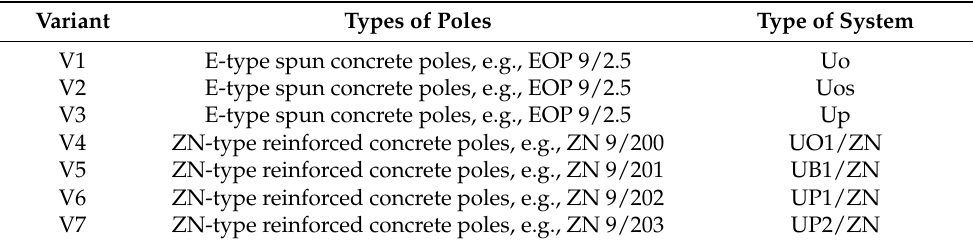
Table 3. Pole variants selected for analysis.